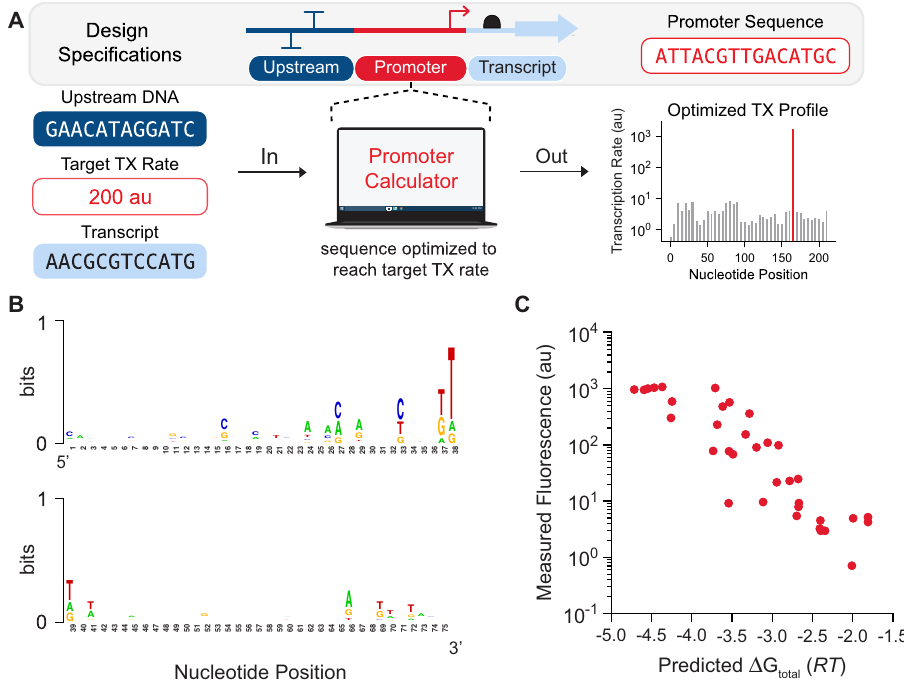
Fig. 5 | Automated Design of Synthetic Promoters. A Promoter sequences were forward engineered with desired transcription rates and start sites. B Sequence analysis of the 75bp forward engineered promoters showed low sequence simi- larity. C Model predictions are compared to in vivo transcription rate